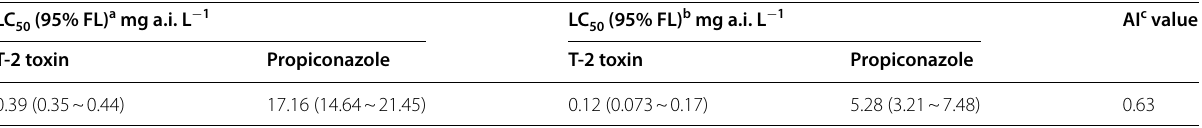
a The LC 50 (95% confidence limit) for T-2 toxin or propiconazole individually b The LC 50 (95% confidence limit) for T-2 toxin or propiconazole in the mixture c AI additive